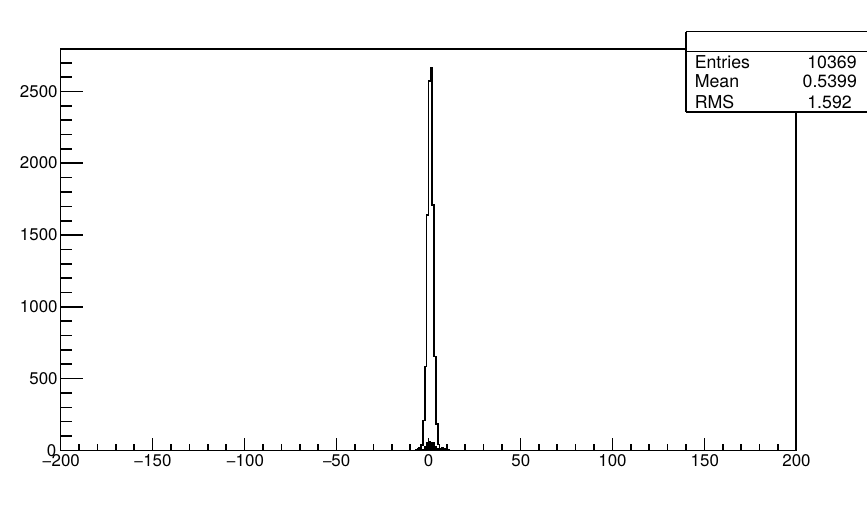
Figure 3. dp-elastic scattering events obtained on the polyethylene and carbon targets